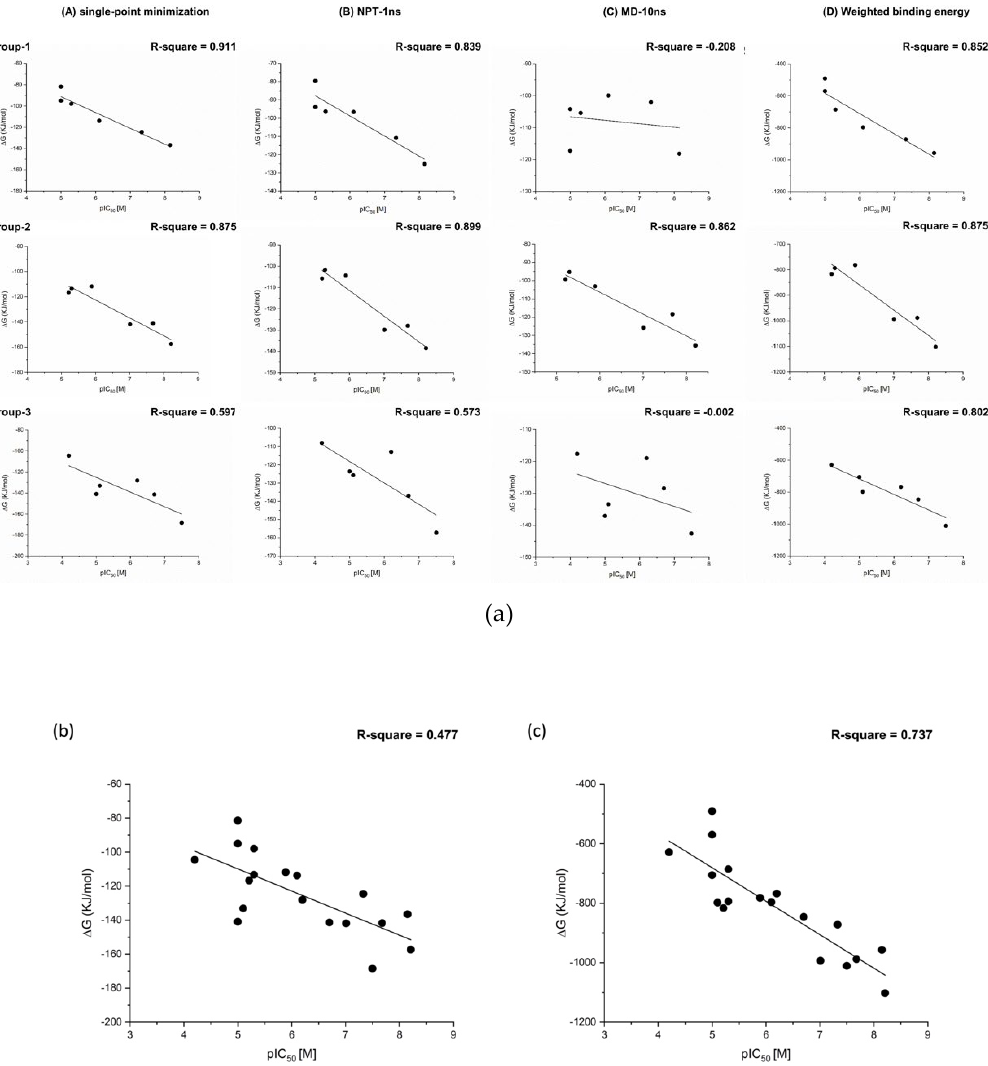
Figure 4. The relationships between the experimental pIC 50 of TNKS-1 inhibitors and binding free energy (kJ/mol) calculations ( a ) column A from single-point minimization; column B from NPT- based simulation; column C from MD-based simulation; column D from weighted binding energy calculation. ( b , c ) The relationship of all experimental pIC 50 of TNKS-1 inhibitors and binding free energy. ( b ) from single-point minimization ( c ) from weighted binding energy calculation.